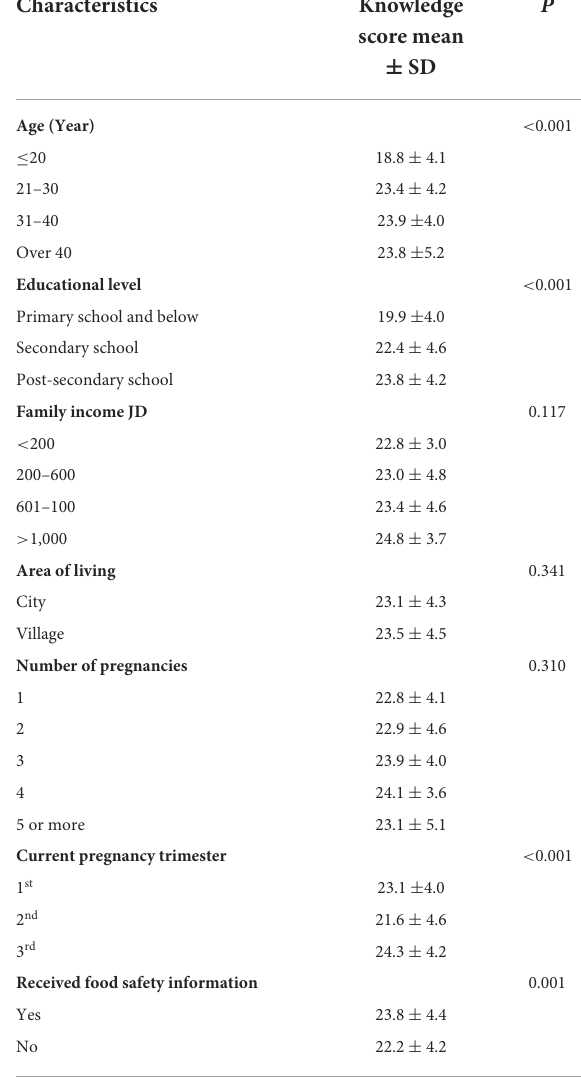
TABLE 8 Query statements and responses 1 of “knowledge of foodborne diseases” domain ( n = 325).